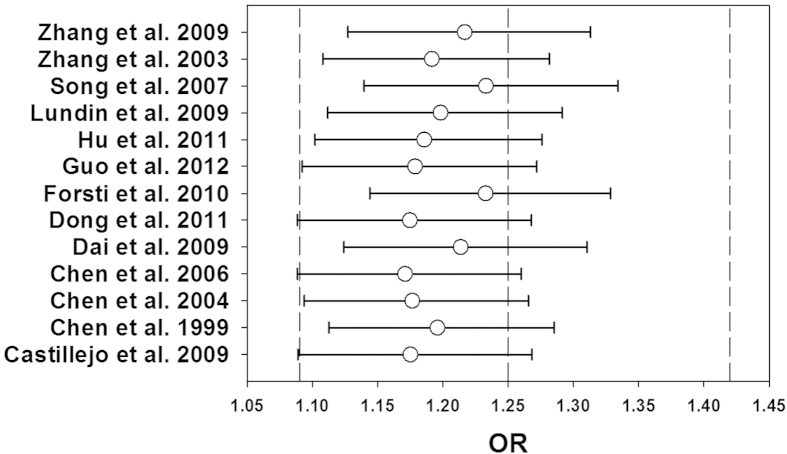
Results of leave-one-out method using allele model.The circles and the horizontal lines represent the ORs and 95% CIs after
omitting studies in turn. The vertical dashed lines show the ORs of 1.09,
1.25 and 1.42.